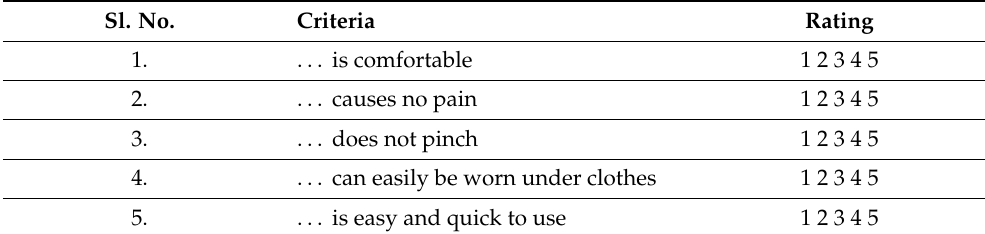
Table 1. The questionnaire on the comfort of each brace. Based on Curfts et al. [5]. Sl.